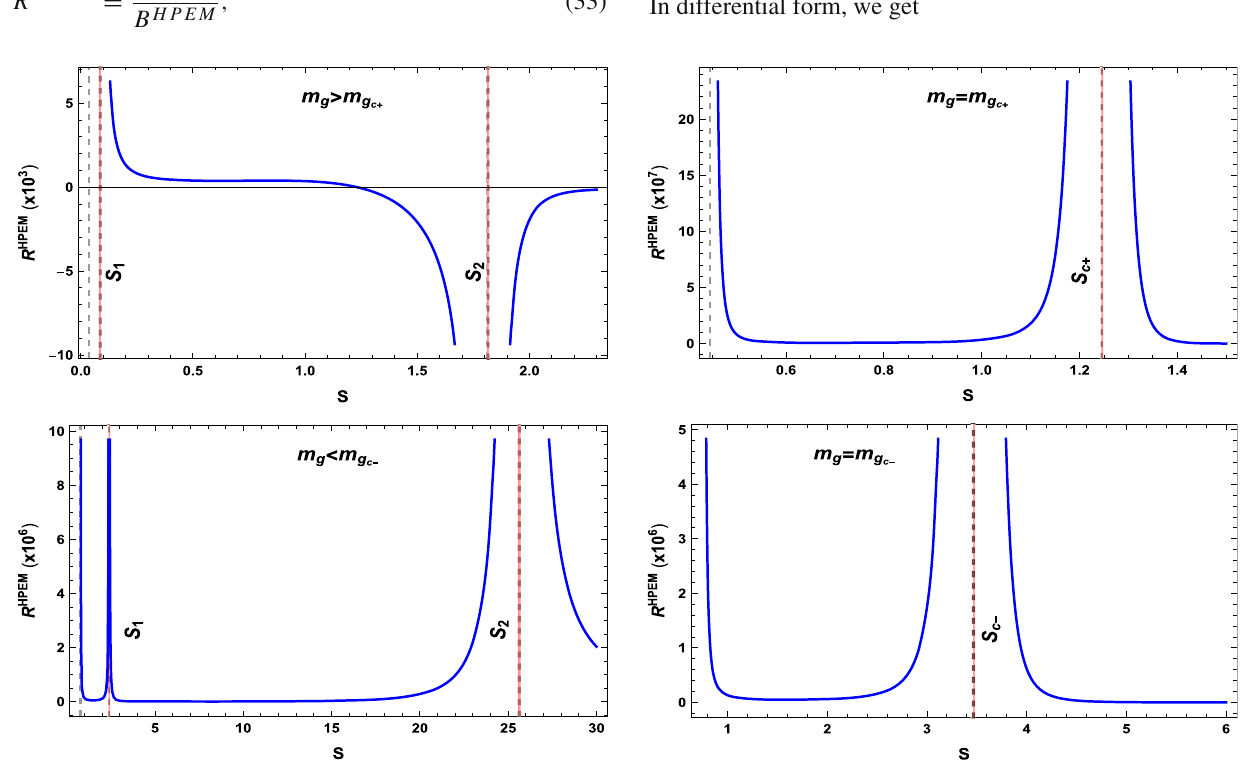
Fig. 9 The scalar curvature versus the entropy for the HPEM metric geometry. The dashed lines correspond to the divergency points of R HPEM and red lines to critical points. We used the following values: Q = 0 . 5, α = 1, β = 2 and c =